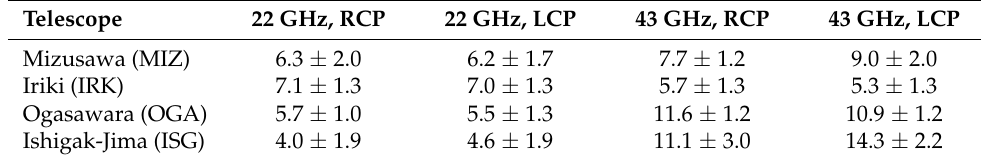
Table 3. D-terms 1 of the 20-m VERA telescopes (expressed in percent).